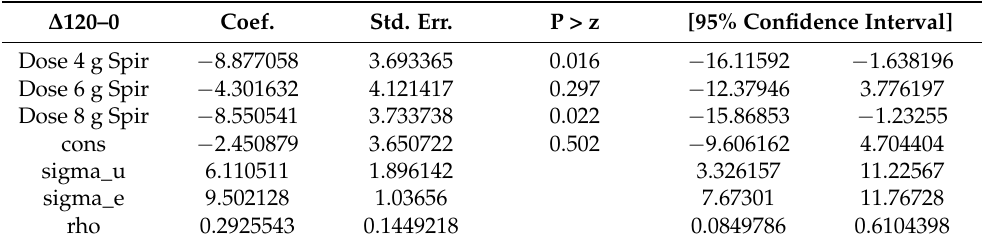
Table 6. Multi-level random effects regression model for differences of mean glucose levels at 120 (cid:48) from the baseline ( ∆